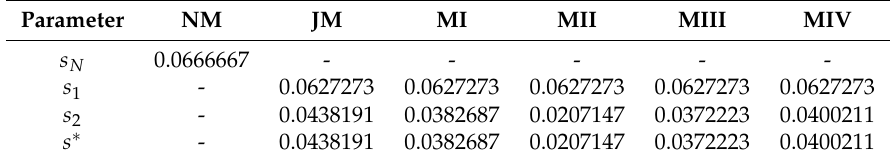
Table 2. Numerical results for Example